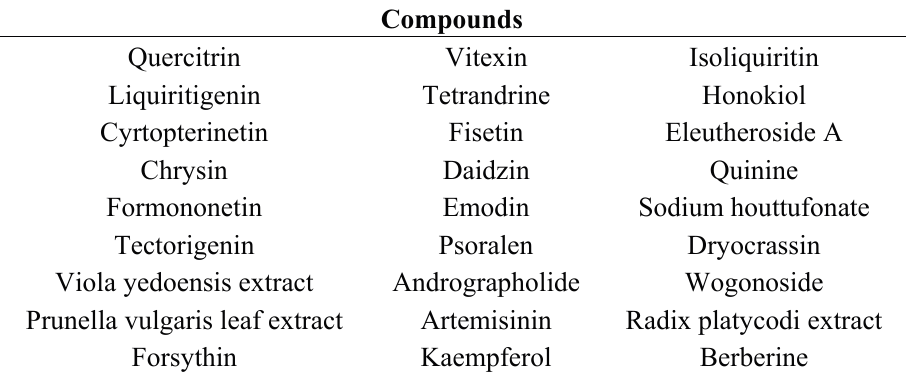
Table 1. Compounds screened.